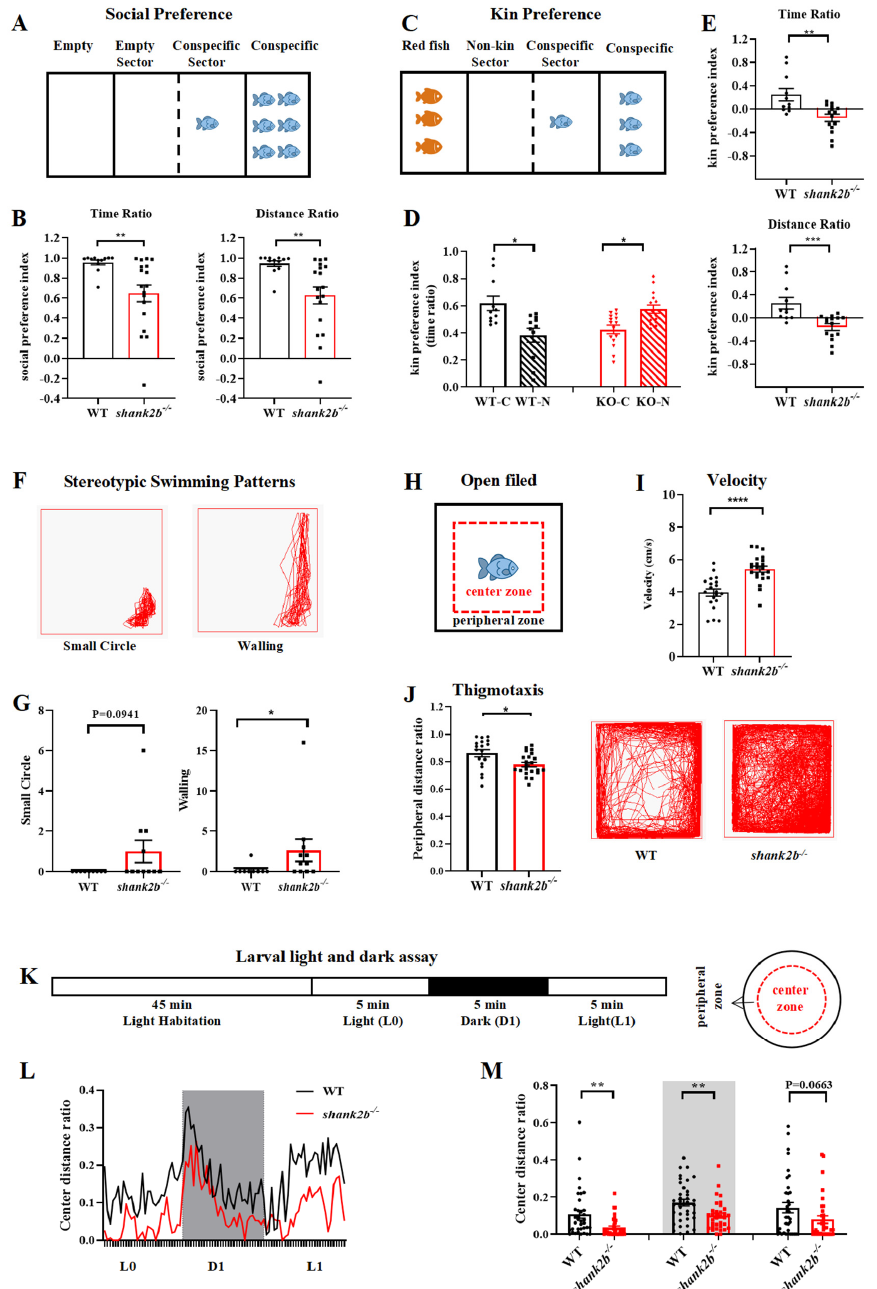
Figure 2. The shank2b − / − deficient zebrafish displayed autism-like behaviors. ( A ) Schematic diagram of the social preference test of adult male zebrafish. ( B ) The shank2b − / − zebrafish displayed a significantly reduced preference for conspecifics compared to WT (time ratio, ** p = 0.0063; distance ratio,